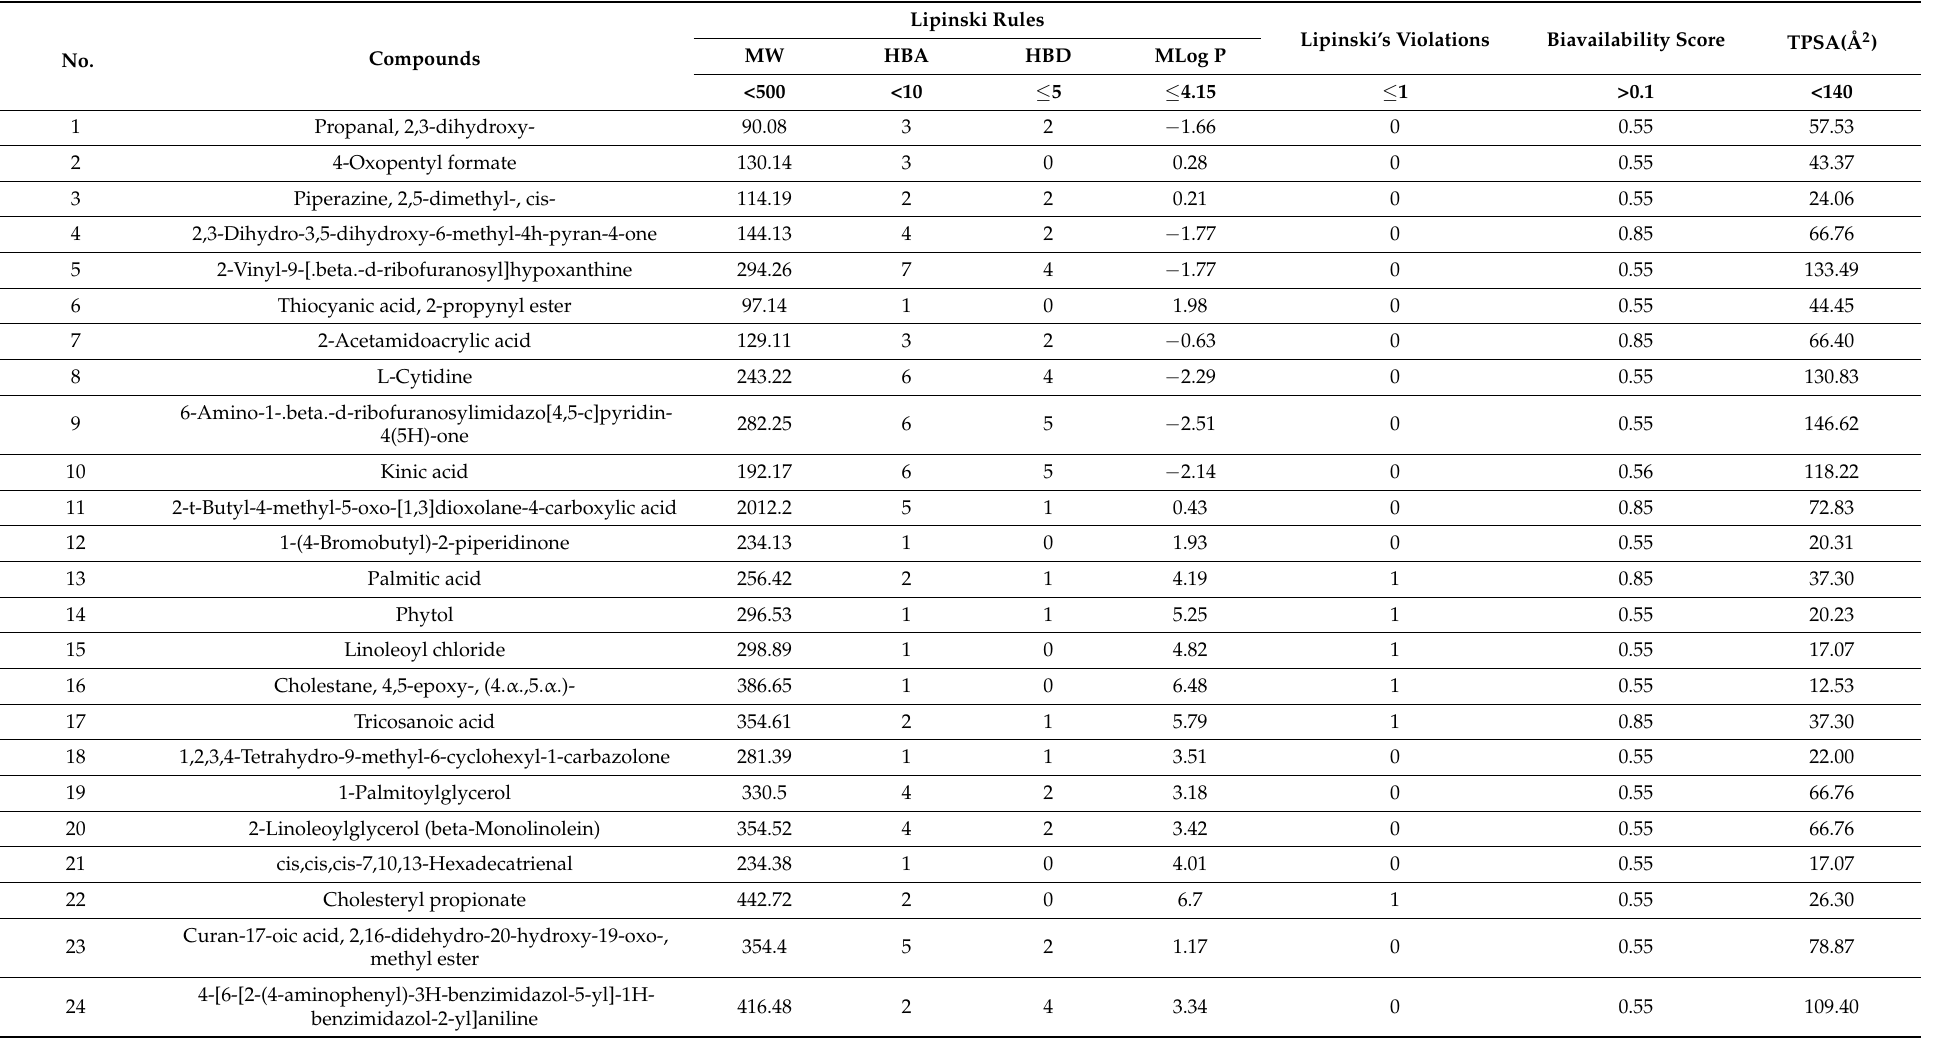
Table 2. Physicochemical properties of bioactives for good oral bioavailability and cell membrane